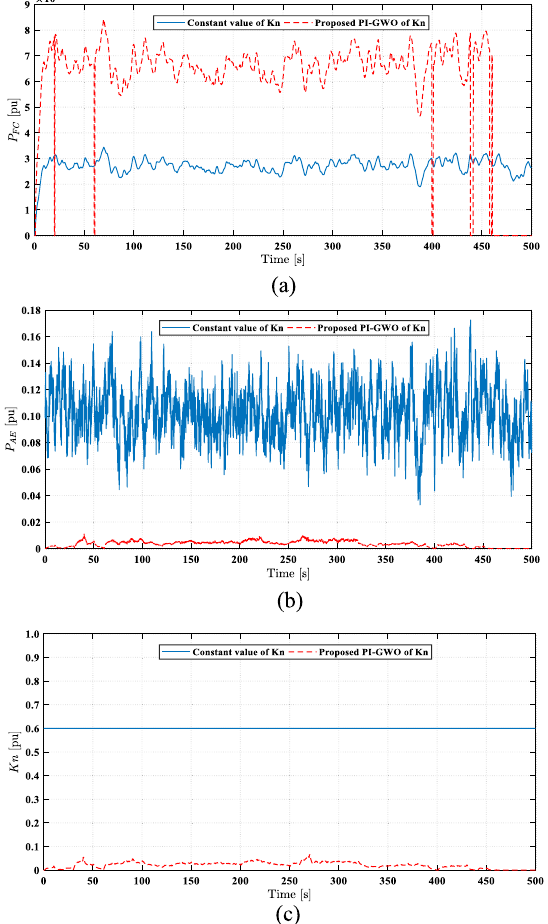
Fig. 12 The Case 2 response of a fuel cell power, b power fed to AE, c value of